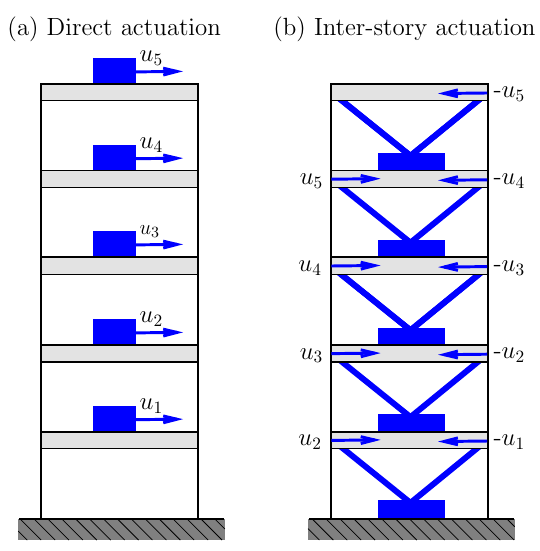
Figure 6: Actuation schemes for a five-story building In the design of the different controllers and the